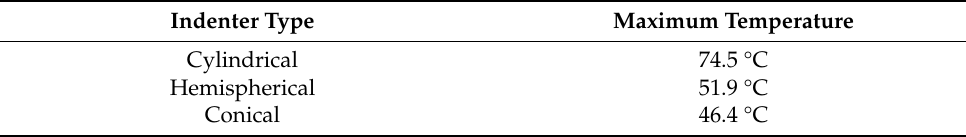
Table 4. Thermal response of a LIB cell under various